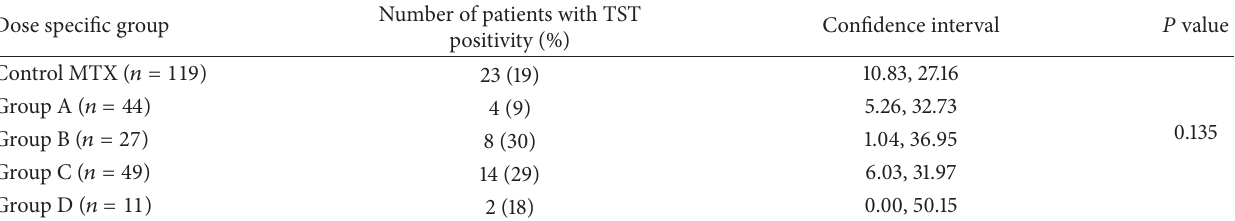
Table 4: Comparison of tuberculin sensitivity among RA patients based on steroid exposure ( 𝑛 = 250 ). Groups based on steroid exposure